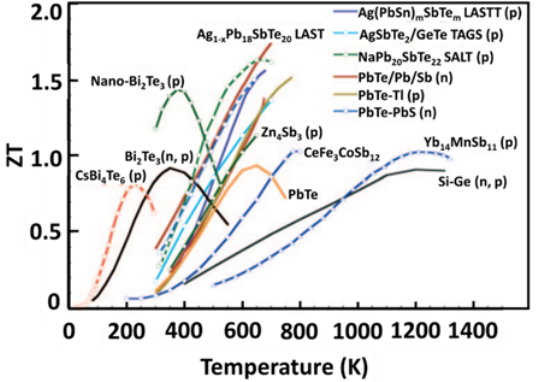
Figure 8. ZT plot of some of the state-of-the-art thermoelectric materials. Adapted from [73], with permission from © 2009 John Wiley and Sons Inc.